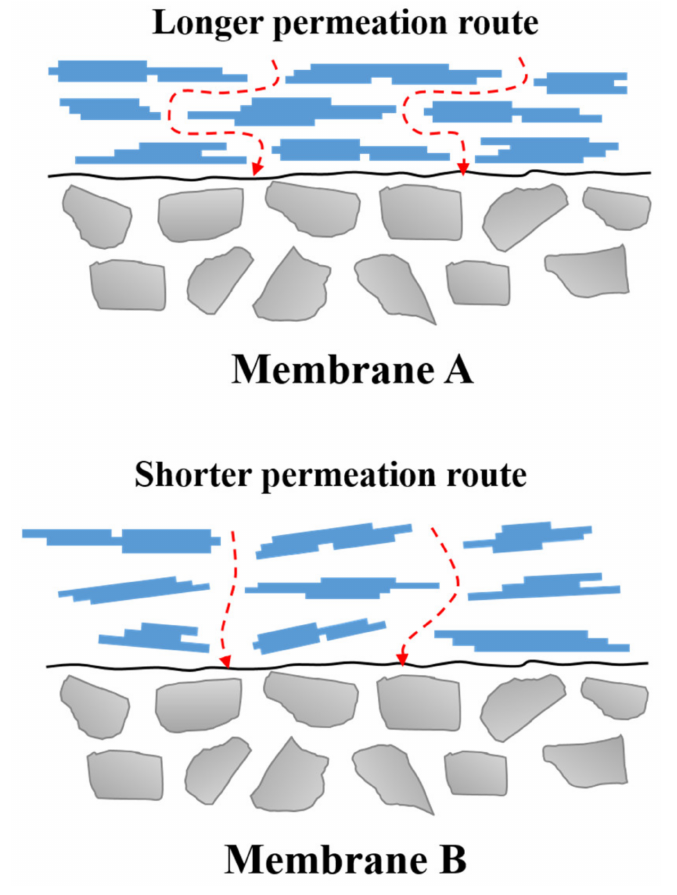
Figure 6. Schematic diagram of the possible permeation routes for membrane A and membrane